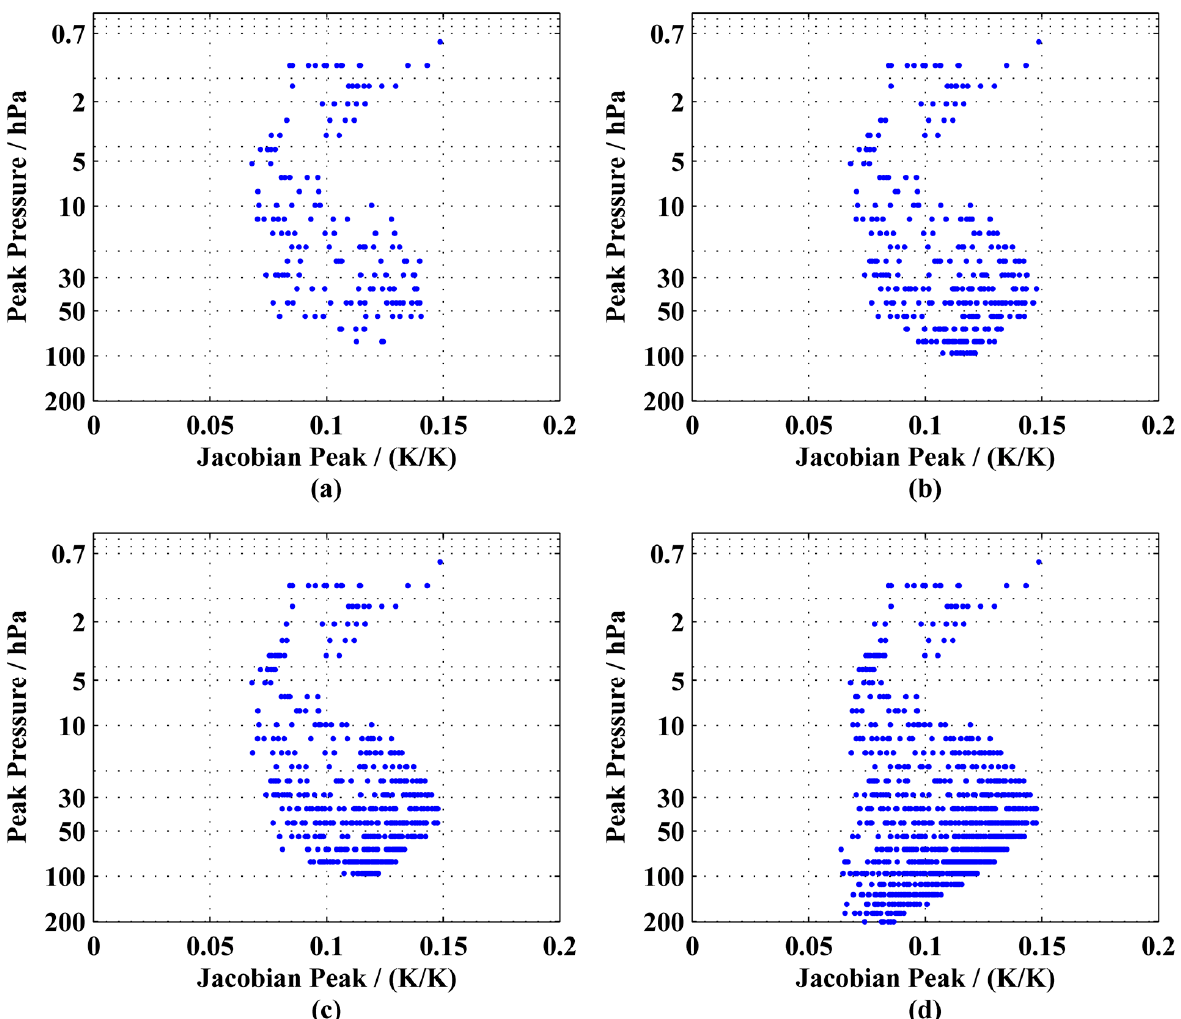
Figure 10. The temperature Jacobian peak corresponding to atmospheric pressure with different spectral ranges and the same spectral resolution of 0.03 cm − 1 . ( a ) A spectral range of 4.8 cm − 1 . ( b ) A spectral range of 9.6 cm − 1 . ( c ) A spectral range of 16 cm − 1 . ( d ) A spectral range of 32 cm − 1 .